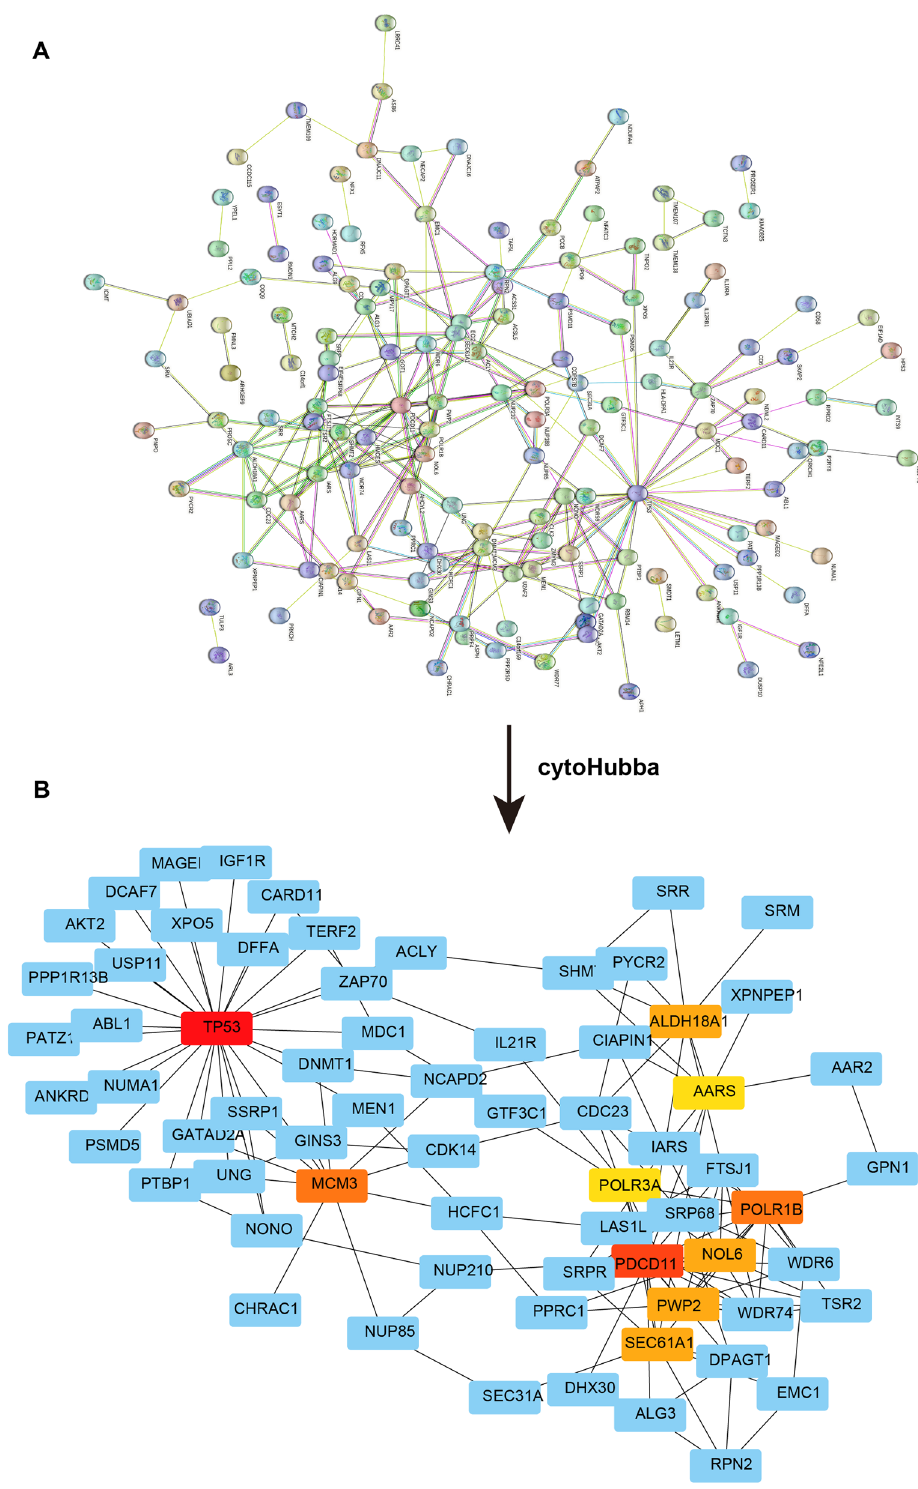
Figure 3. PPI network analysis. ( A ) PPI analysis for all DEGs. Network nodes represent proteins. Edges represent protein–protein associations. Light blue and purple edges mean known interactions; Dark blue, green, and red edges mean predicted interactions. ( B ) The network of 10 hub genes determined by the cytoHubba. The darker the color, the higher the degree